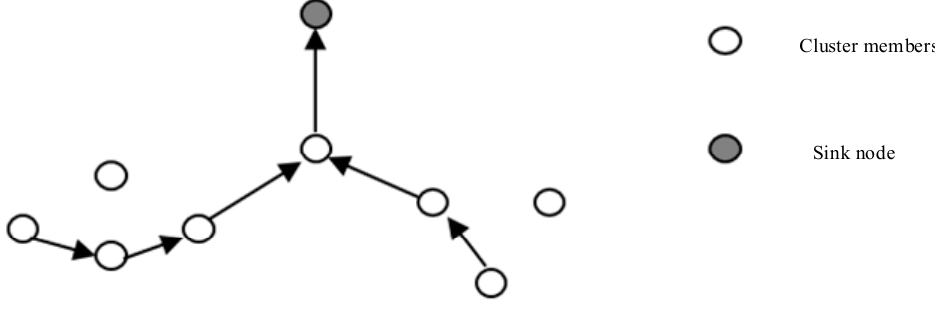
Figure 4. Example of single-chain structure.